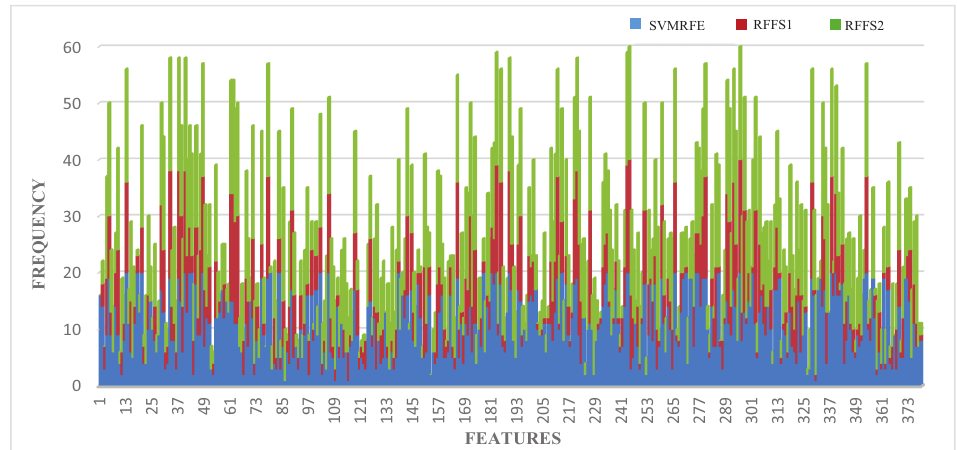
Figure 4. SVMRFE, RFFS-GI and RFFS-OOB results of FNC